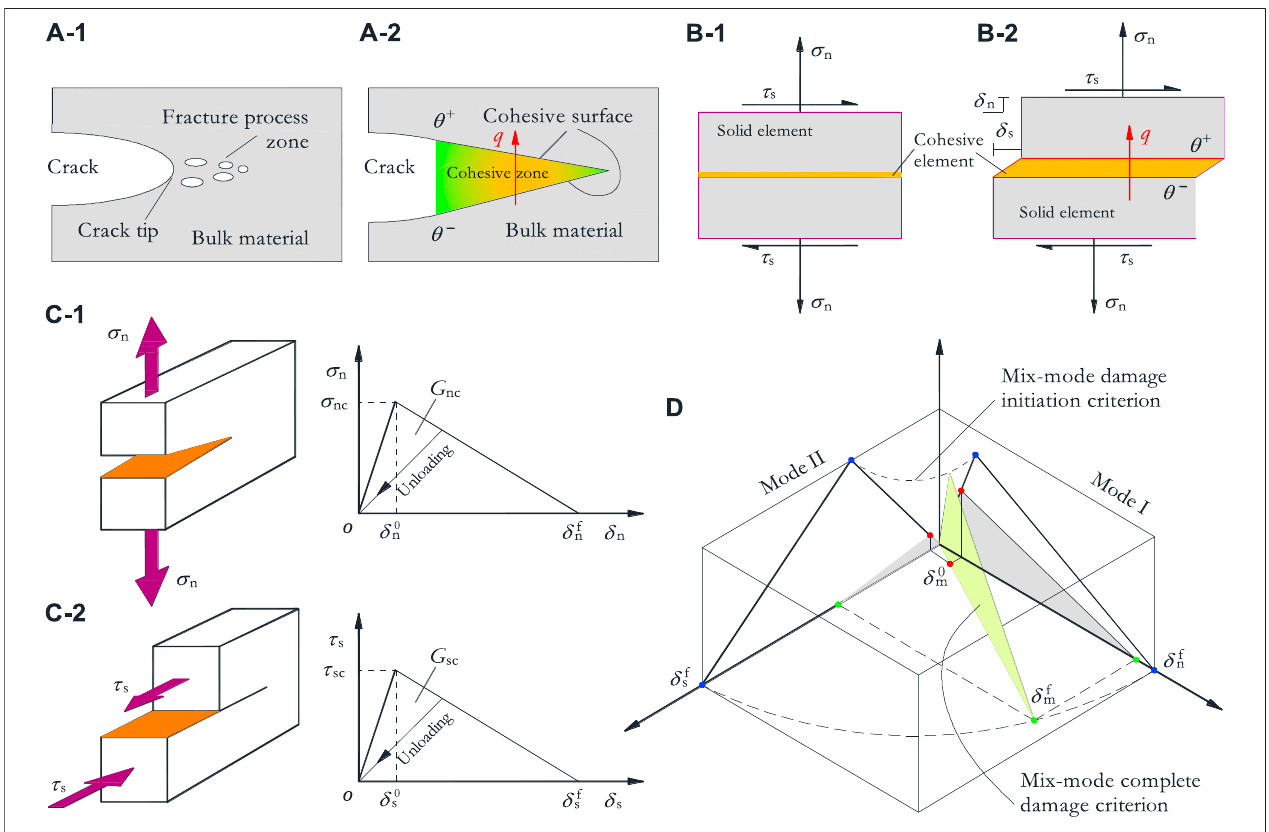
FIGURE 1 | (A-1) Fracture process zone; (A-2) Equivalent cohesive interface model [23, 24]; (B) Schematical illustration of thermal-mechanical behavior of cohesive interface model; (C) Bi-linear traction-separation law under Mode I and Mode II fracture of a cohesive interface [25]; (D) Mixed-mode bi-linear traction- separation law of a cohesive interface